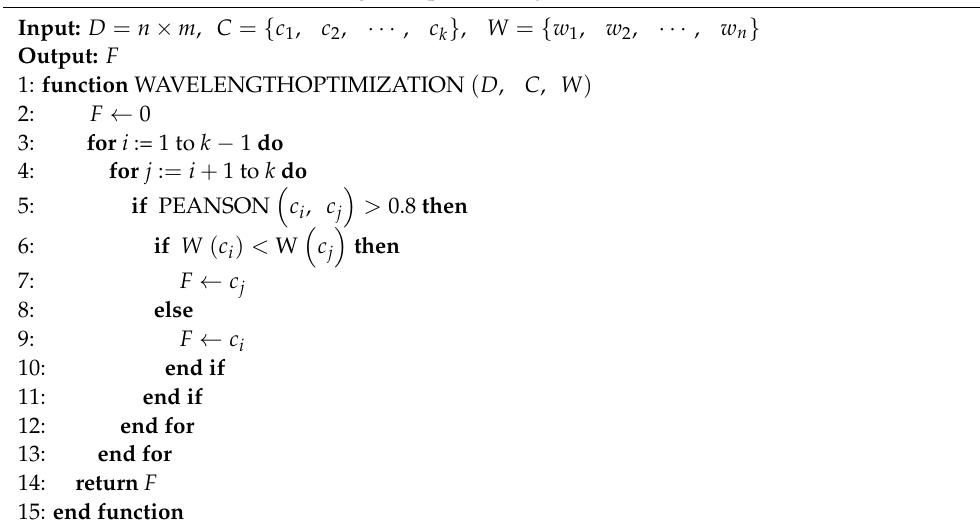
Algorithm 1. The feature wavelength is optimized by